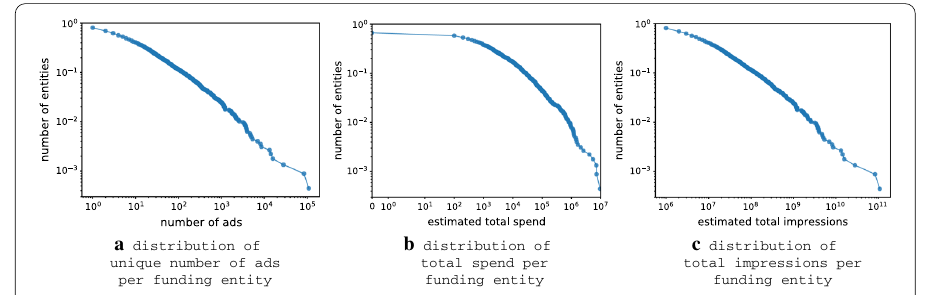
Fig. 3 Complementary cumulative distribution function (CCDF) of funding entities’ ( a ) total number of unique ads ( b ) estimated total spend ( c ) estimated total impressions. For a given x value, the CCDF is defined as the number of funding entities that, for example, spent at least x dollars on their ads in aggregate. Note that some funding entities have an estimated total spend and estimated total impressions equal to zero as a consequence of summing the lower ends of each ad’s respective